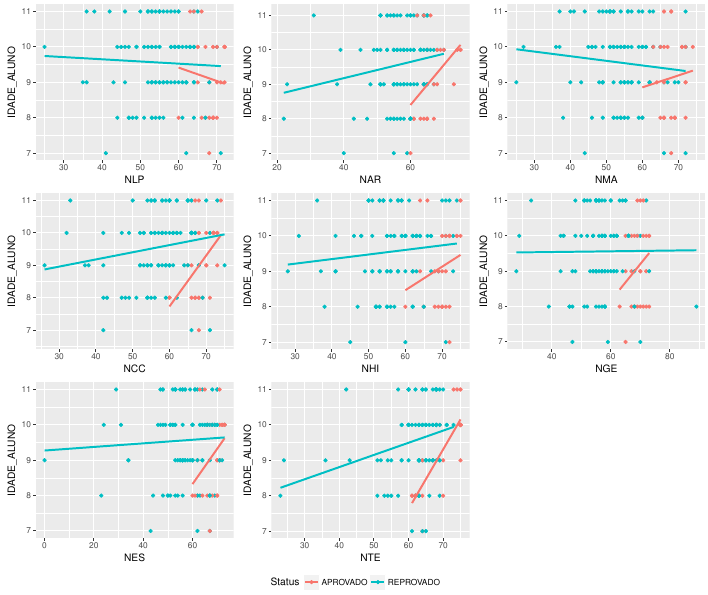
Figure 11. The correlation between discipline’s grade and student’s